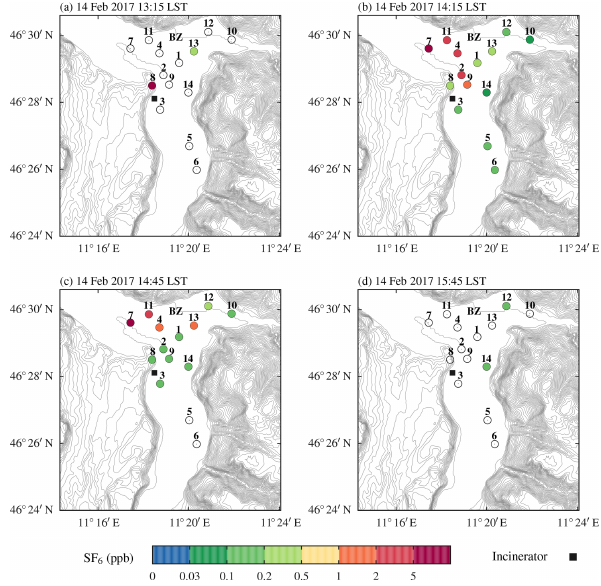
Figure 10. Spatial distribution of the tracer concentrations mea- sured during the release performed in the afternoon of 14 February 2017. The position of the city of Bolzano is indicated in the map with the label